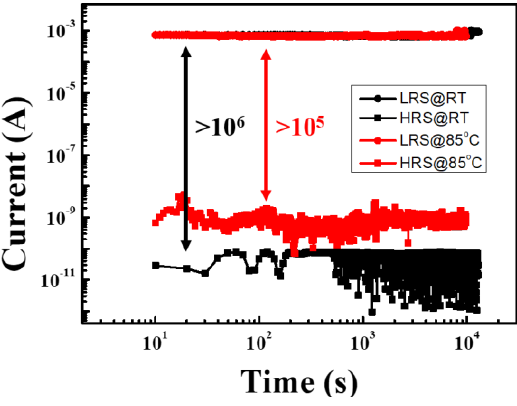
Figure 13. Data retention characteristics of Al/MZN NR/ITO RRAM devices measured at 0.1